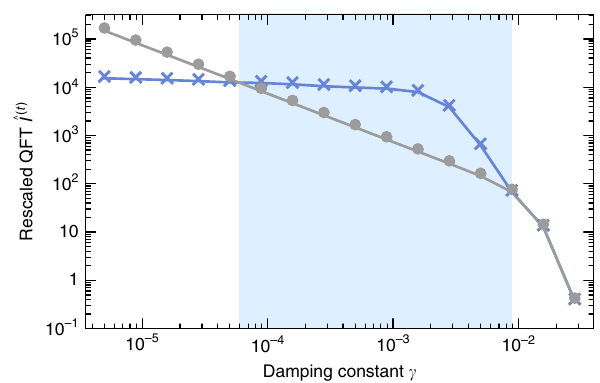
Fig. 6 Enhancement in measurement precision through kicking (blue crosses) is found over a broad range of damping strengths. Comparison of the maximal rescaled quantum Fisher information ^ I t ð Þ α for the dissipative top (gray dots) and the dissipative kicked top (blue crosses); kicking strength k = 30 and spin size j = 100. In both cases, ^ I t ð Þ α was optimized over the location of initial coherent states. The blue-shaded area marks the range 1.2 ≲ 2 γ J 2 ≲ 180 where the reference is